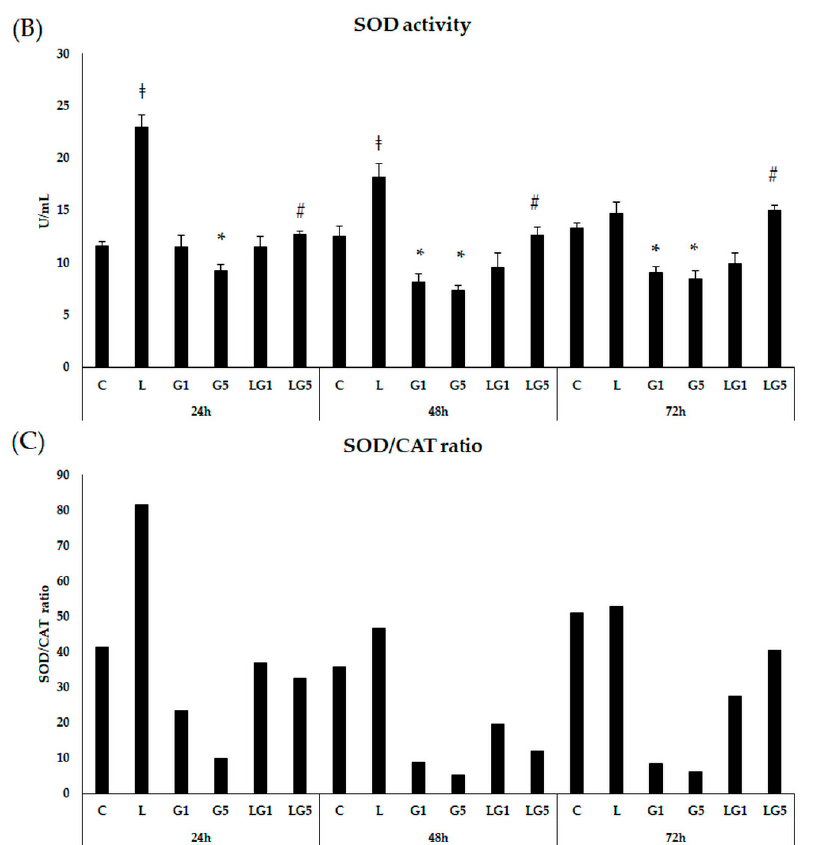
Figure 3. Determination of the effects of lutein on CAT activity ( A ), SOD activity ( B ), and SOD/CAT ratio ( C ) of the SH-SY5Y cells. SH-SY5Y cells were treated with 10 ng/µL of lutein, 1 mM, or 5 mM Glu, or lutein with Glu together to detect the changes in enzyme activity. The cells were incubated for 24 h, 48 h, and 72 h at 37 °C and 5% CO 2 . After incubation, the activity of the CAT enzyme was determined by the Catalase Assay kit, and the result was expressed as nmol/min/mL. The activity of the SOD enzyme was determined by the Superoxide Dismutase Activity Assay kit, and the result was expressed as U/mL. The bars represent the mean values (±standard deviation error bars, SD) of three independent experiments ( n = 3) performed in triplicate and are presented relative to their control cells. The * marks the statistical significance of Glu treatments compared to control, ‡ shows the statistical significance of lutein treatments compared to control, # signs the statistical significance of combined (lutein with Glu) treatments compared to the Glu treatments at 24 h, 48 h, and 72 h ( p <